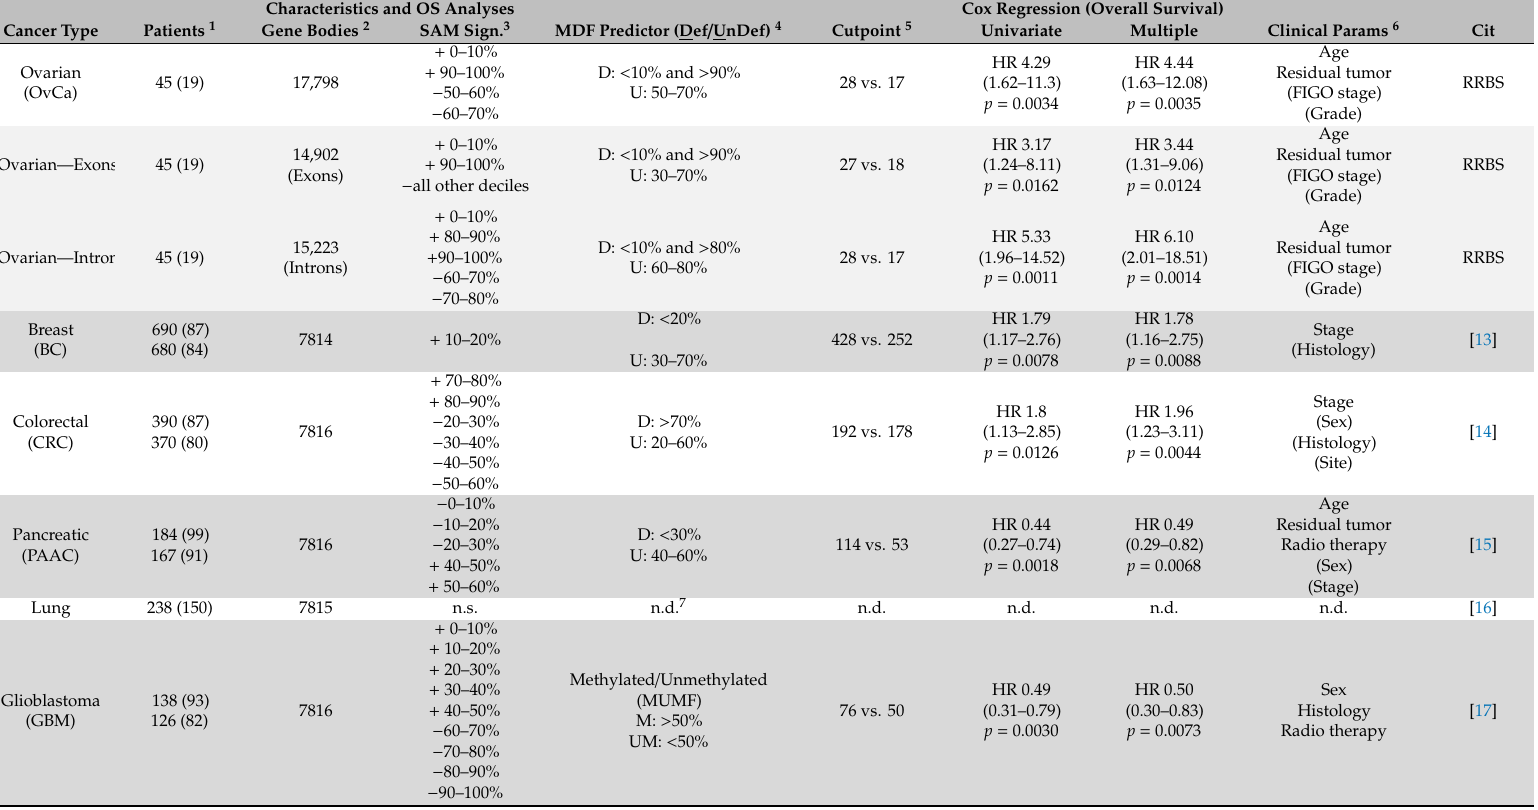
Table 1. Overview of Characteristic Numbers (Samples, Death Event Numbers, Significant Deciles, Dichotomized Numbers, Hazard Ratios, and p -Values of Single and Multiple Cox Regression Analyses and Included Clinicopathologic Factors) of Cancer Types Analyzed in This Study (the grey shadow indicates subanalyses for ovarian cancer and is otherwise alternating for better